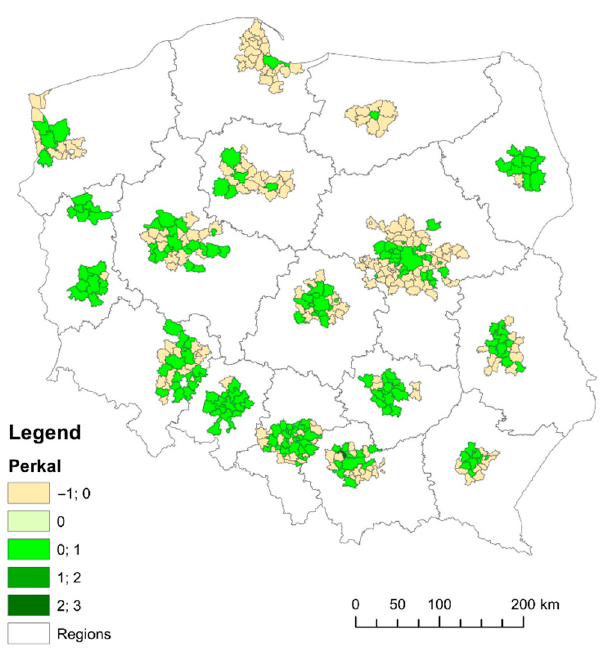
Figure 2. Urban Sprawl Index in the analyzed communes based on the Perkal method P(i). Source: own study based on Lity ń ski [6].